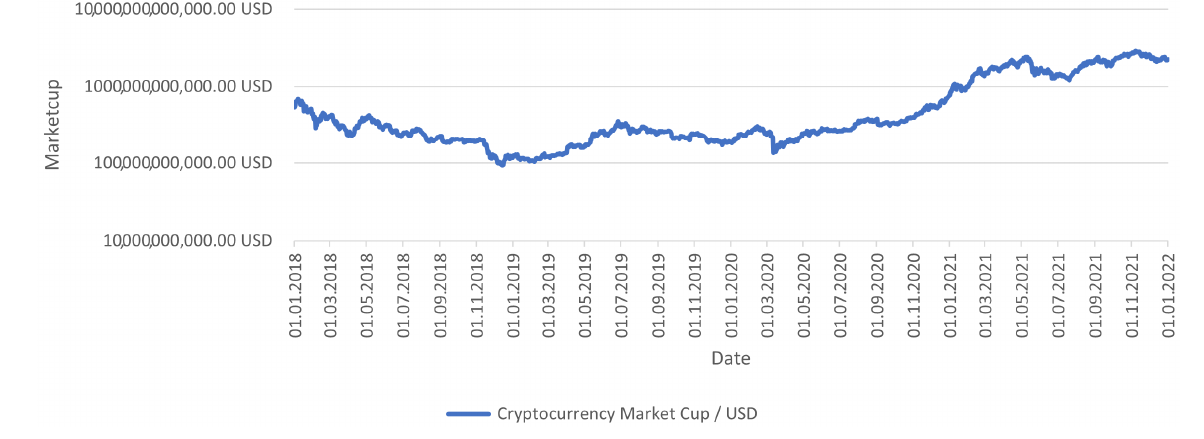
Figure 3. Cryptocurrency total market cup in the period under study.